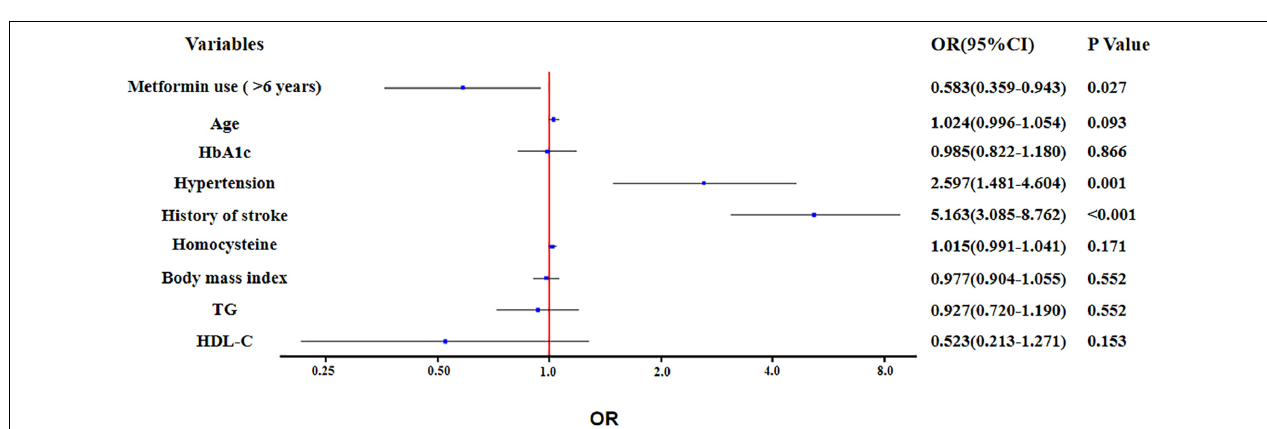
FIGURE 1 | Binary logistic regression analysis for the associated factors with cognitive impairment.